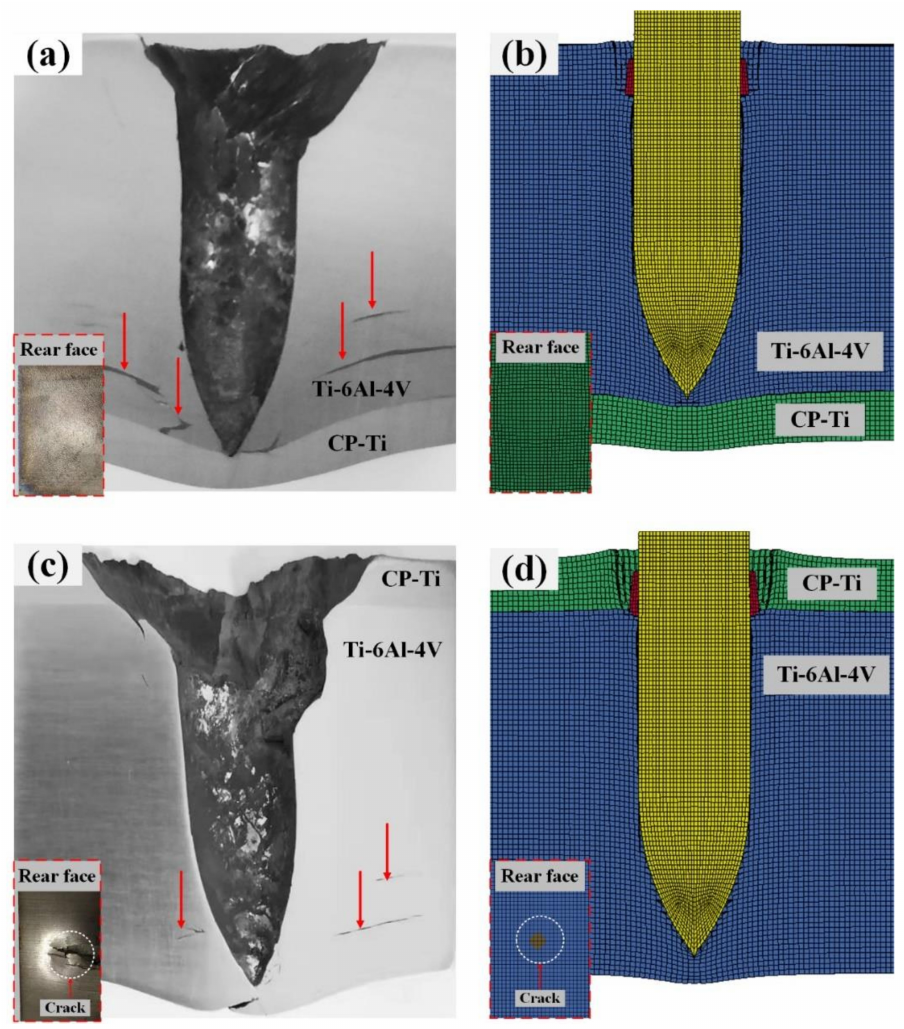
Figure 6. Macro morphologies of the cross-section along the penetration channel of the Ti6Al4V / CP-Ti laminated composite armor: ( a , c ) Experimental results and ( b , d ) simulation results of the Ti64 / CPTi plate and CPTi / Ti64 plate,